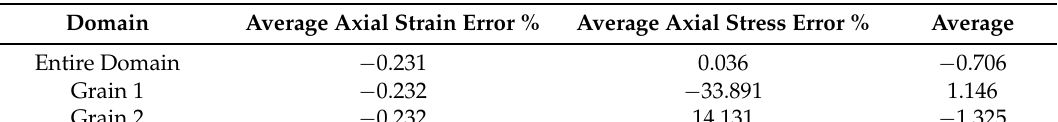
Table 2. Maximum percentile error of the GMC solution (compared to FEA) for the two-grain polycrystal sample. Figure 5. ( a ) Average axial strain ( ε zz ) vs . load-step; ( b ) average axial stress ( σ zz ) vs . load-step; ( c ) von Mises stress vs . load-step for the individual grains, Grain1 (G1) and Grain 2 (G2).